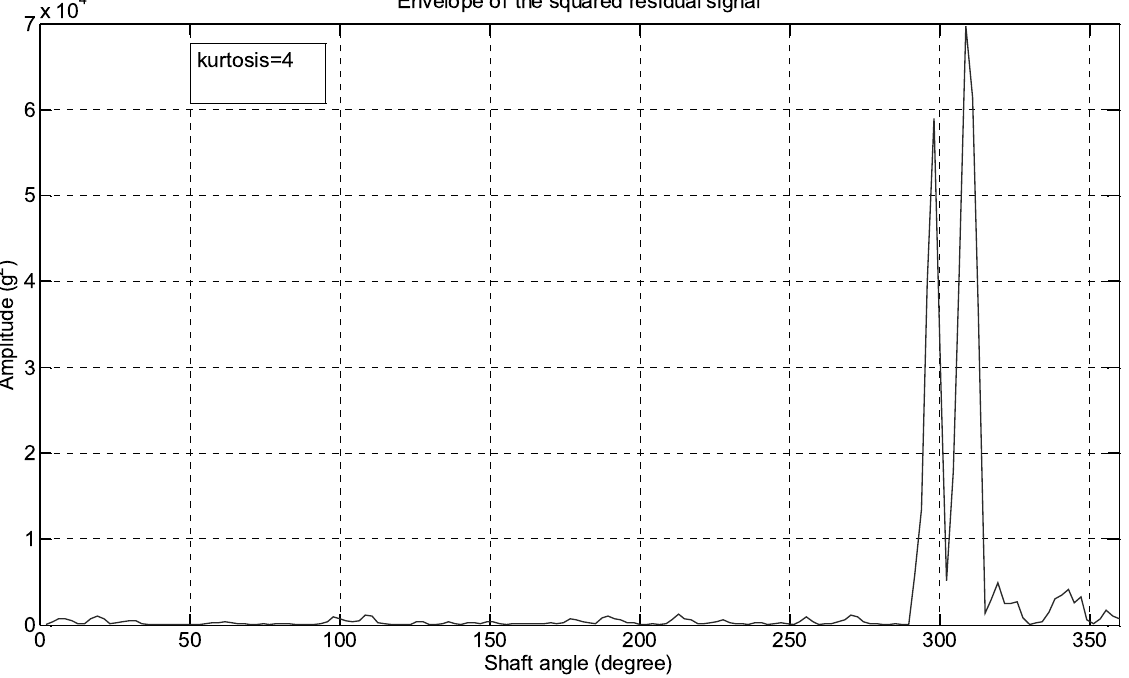
Fig. 24. Envelope of the squared residual signal in the time domain for the fully broken tooth (between 4th and 5th harmonic.